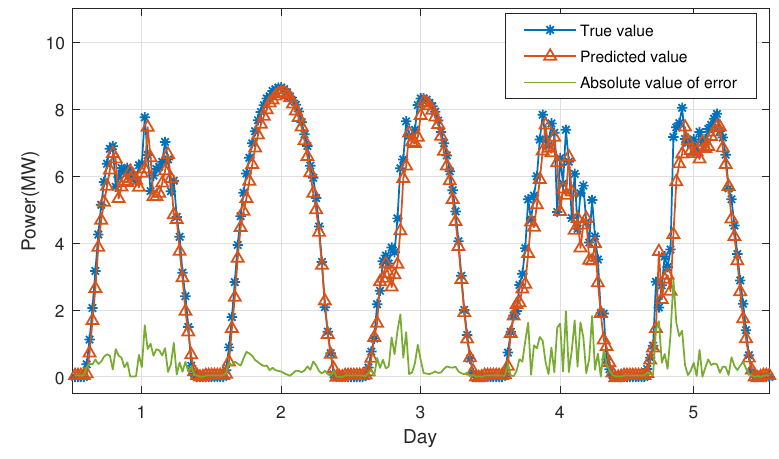
Figure 9. A random five-day forecasting curve.